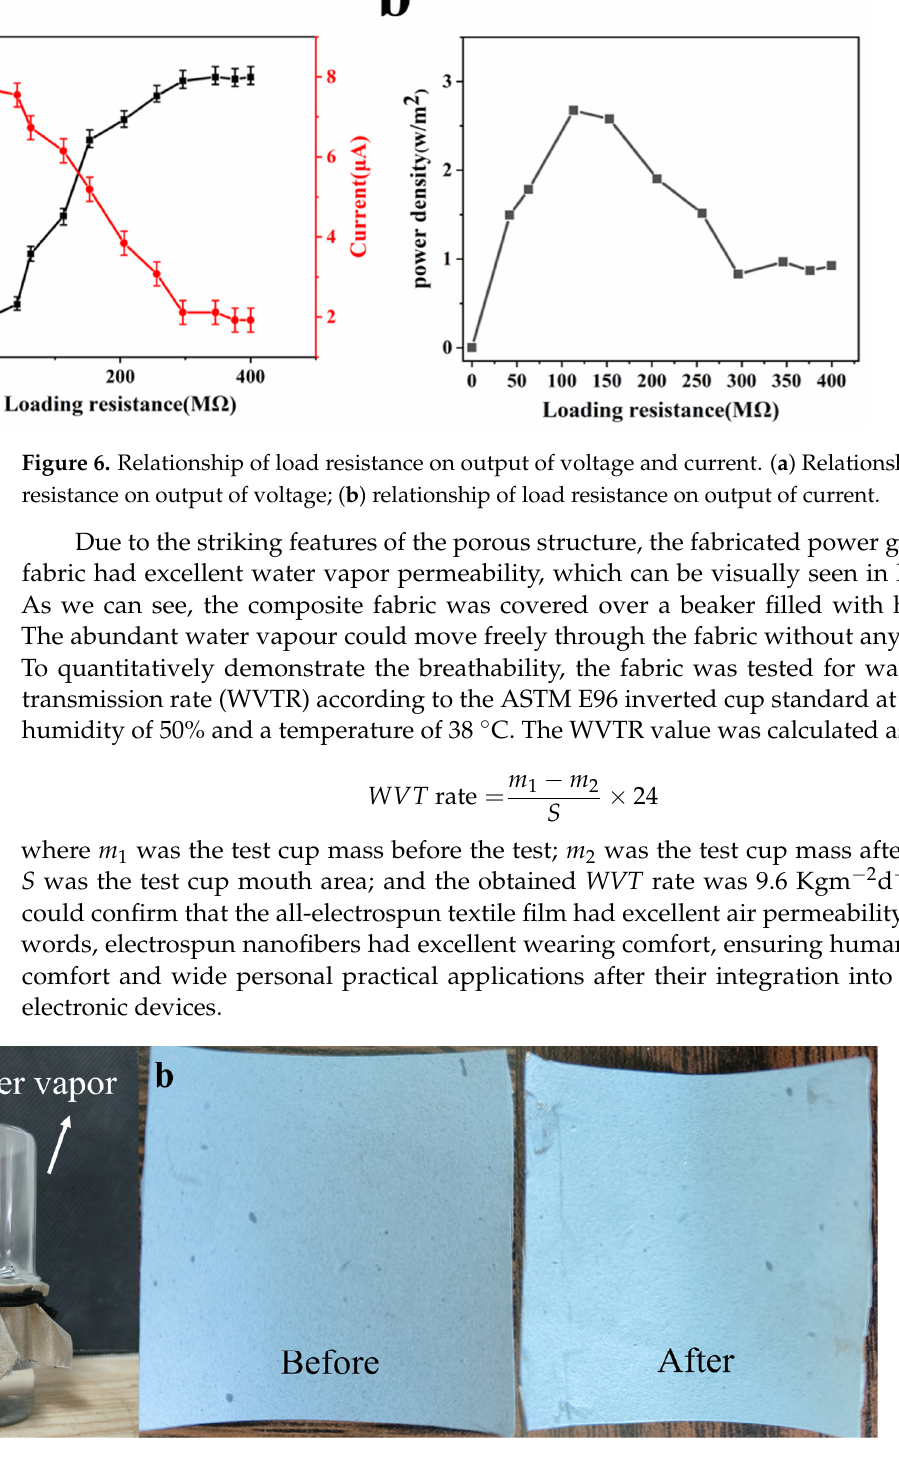
Figure 7. ( a ) Water vapor transmission rate test (WVT); ( b ) comparison before and after a thousand times of bending.